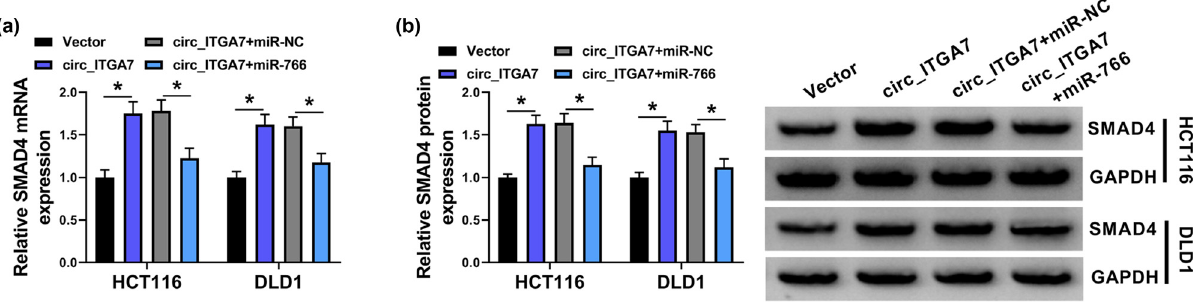
Figure 7: circ_ITGA7/miR - 766 axis mediates SMAD4 expression. ( a and b ) qRT - PCR and western blot analysis of SMAD4 levels in HCT116 and DLD1 cells transfected with Vector, circ_ITGA7, circ_ITGA7 + miR - NC, or circ_ITGA7 + miR - 766. * P <